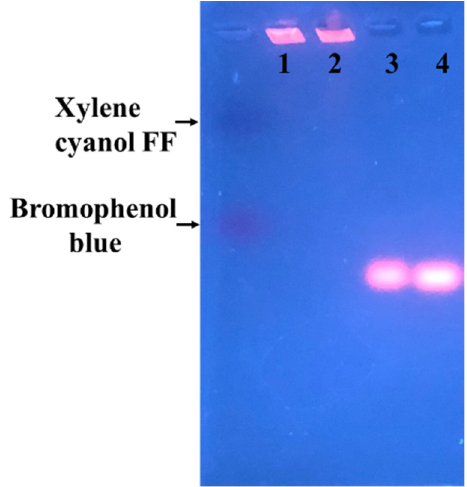
Figure 6. Electrophoretic mobility of Au NCs on 2% agarose gel. The samples on Lanes 1 and 2 are DTT-Au NCs. Lanes 3 and 4 are glutathione-Au NCs. Bromophenol blue and xylene cyanol FF, as references, are indicated.